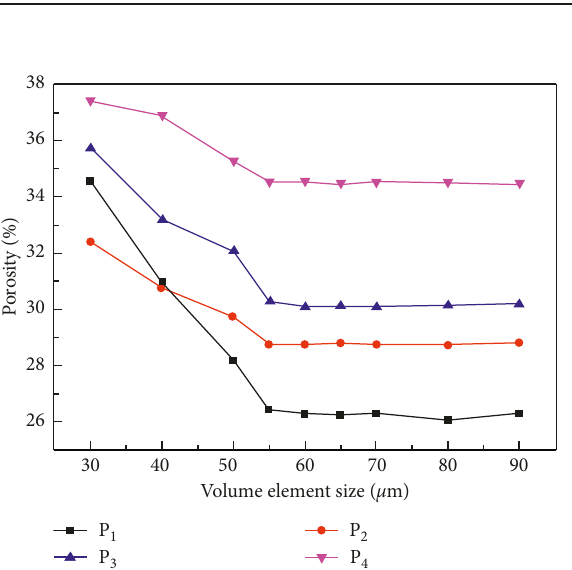
Table 2: Calculated results of coal rock porosity using different points (P Size of the volume element ( μ m) Calculated porosity using P 3 as the voxel center (%) Calculated porosity using P 4 as the voxel center (%)